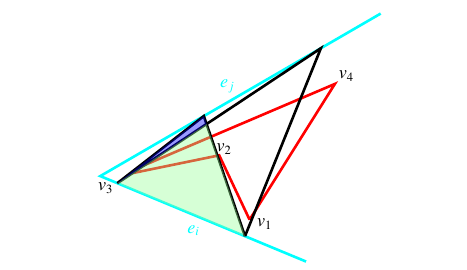
(b) Leak: Keeping vertices v i and (a) Real twists type 2: Re- v i + 4 as the locally first and last pro- moving twists by renumber- jected vertices eliminates the leak. ing. Figure 6. Removing real twists of type 2 and